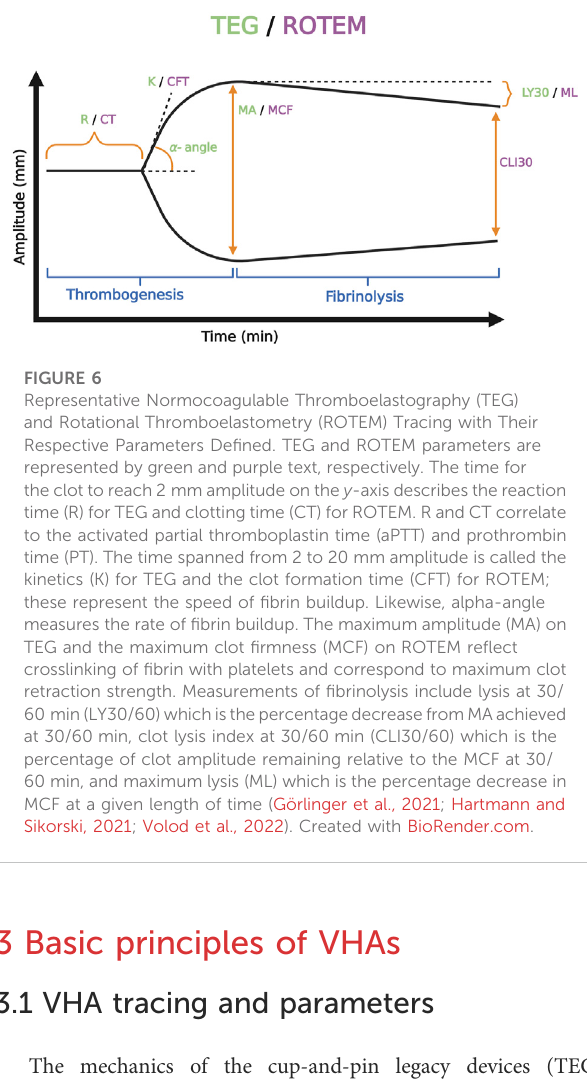
Figure 6 exempli fi es the typical normocoagulable TEG/ROTEM